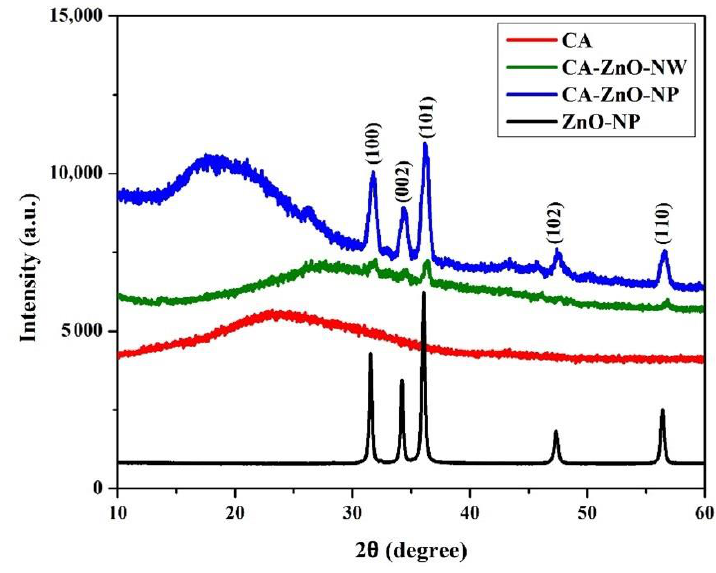
Figure 2. XRD patterns of the pristine CA, CA-ZnO-NP, and CA-ZnO-NW membranes.